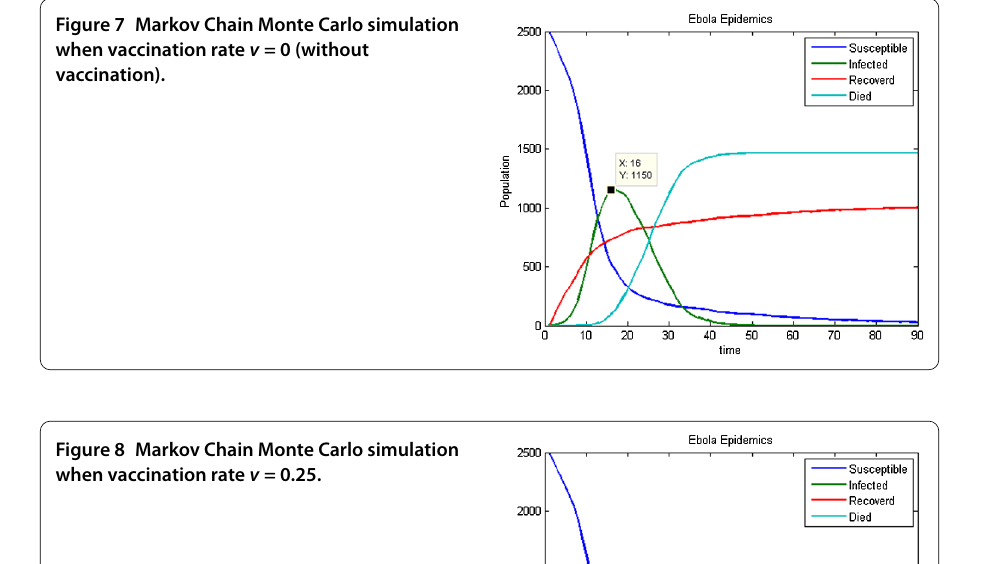
Figure 8 Markov Chain Monte Carlo simulation when vaccination rate v = 0.25.